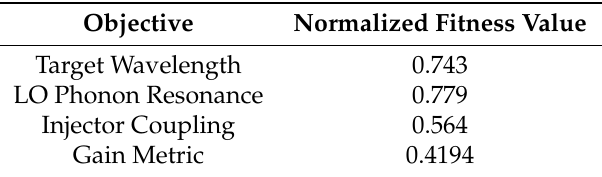
Table 3. Reference design fitness